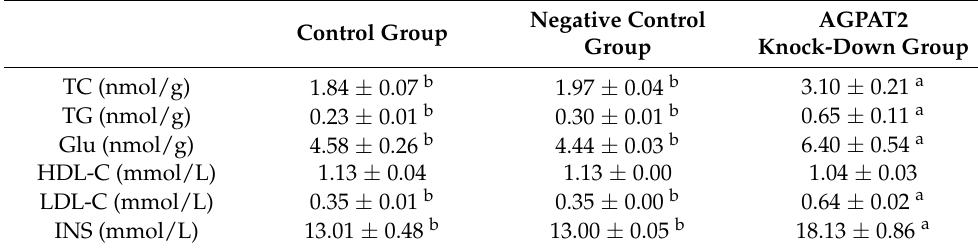
Table 3. Serum indexes for control, negative control, and AGPAT2 knock-down groups.